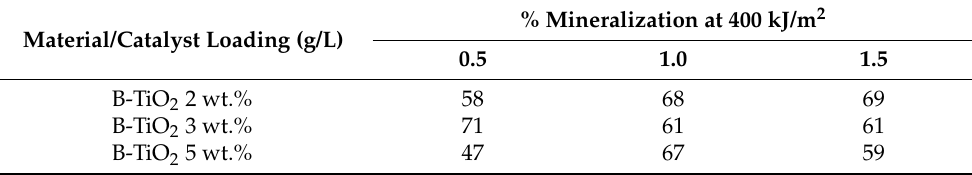
Table 3. Mineralization of E3 solution (10 mg/L) with B-doped TiO 2 materials. Material/Catalyst Loading